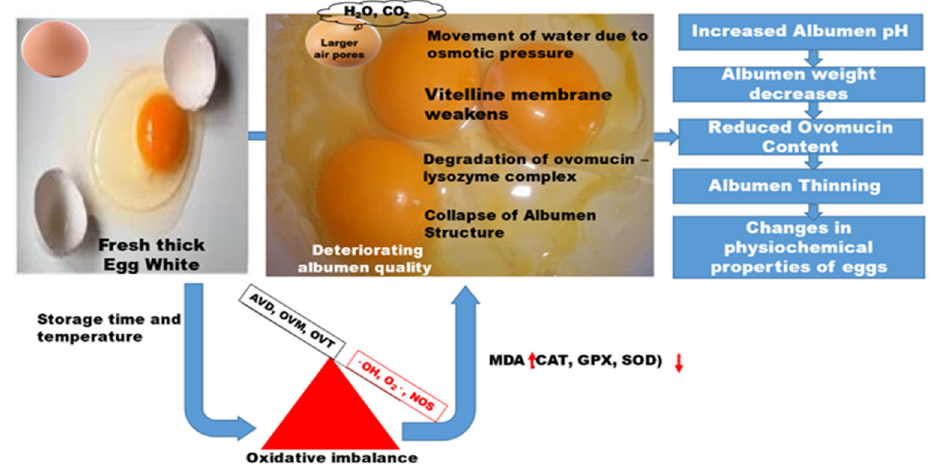
Figure 1. Changes in albumen structure during storage.